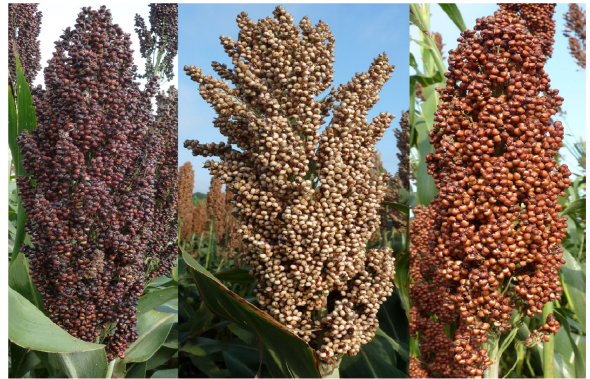
Figure 1. Mature panicles of different types of sorghum in the field. Black (left), white (middle), and red (right) sorghum (Adapted from Awika [27]).